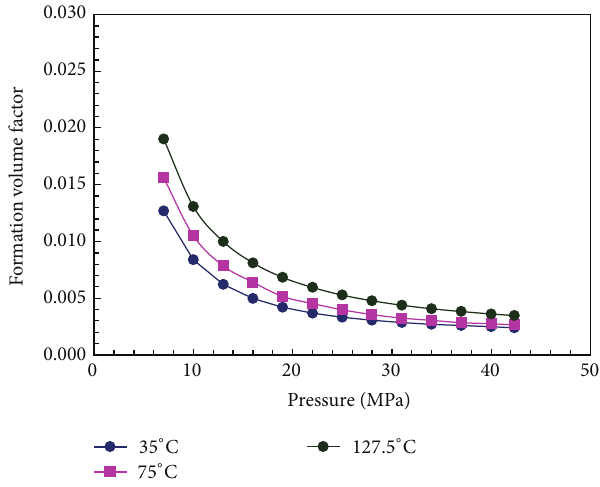
Figure 7: Variation of the gas density of YP9 gas sample with pressure under different temperatures.